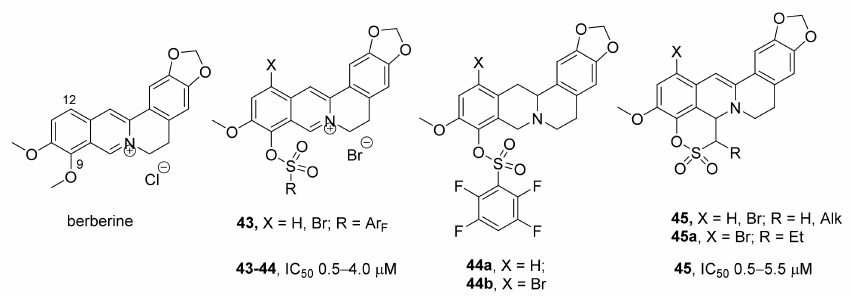
Figure 13. Berberine derivatives that are inhibitors of